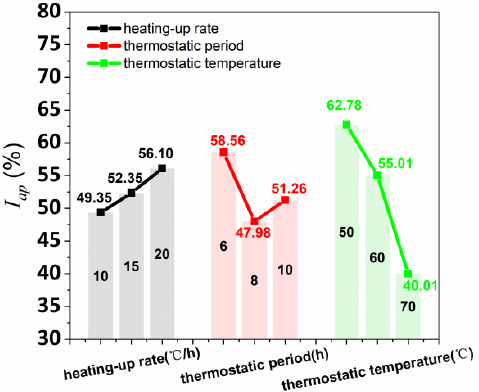
Figure 10. I ap affected by various heating-up rates, thermostatic periods, and thermostatic tempera- tures.